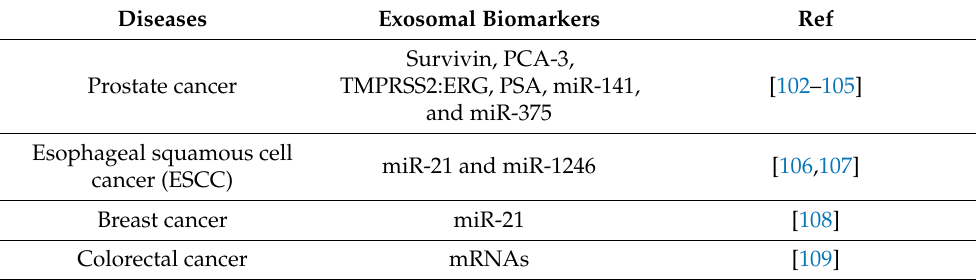
Table 2. Examples of exosomal biomarkers with diagnostic potential in